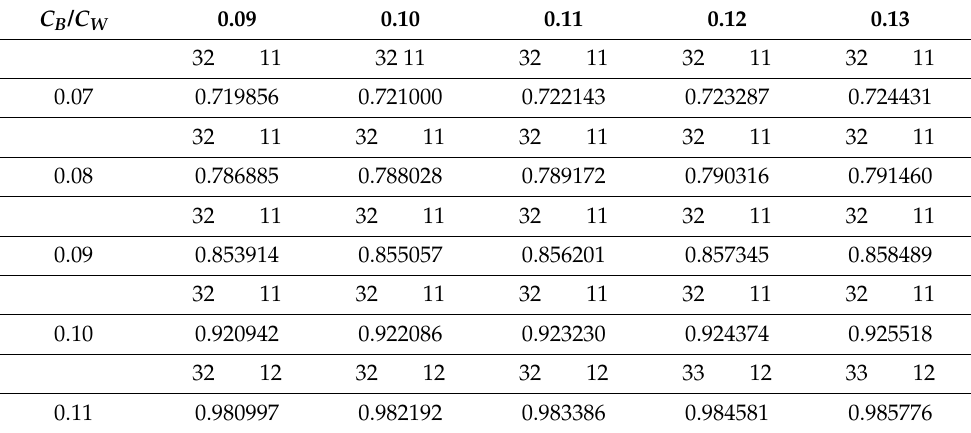
Table 5. Impact of C W and C B costs on the optimal